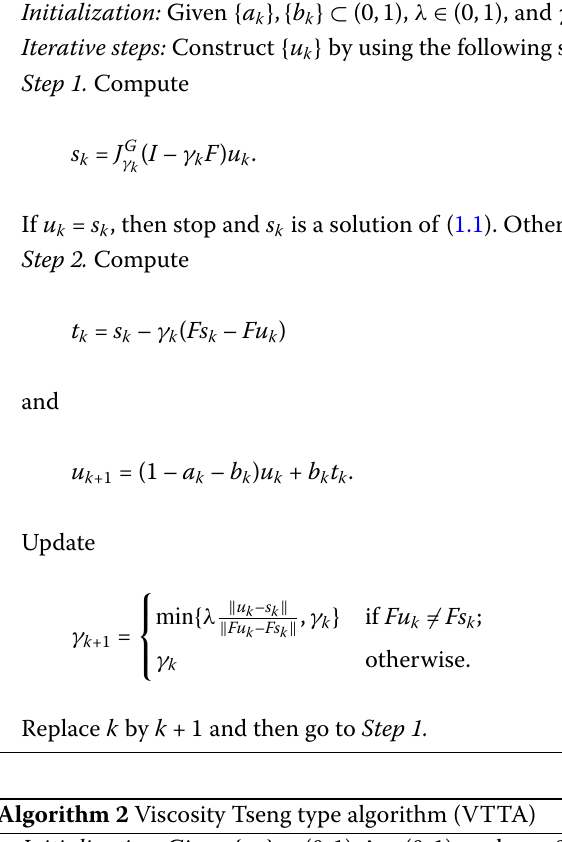
Algorithm 1 Mann Tseng type algorithm (MTTA)